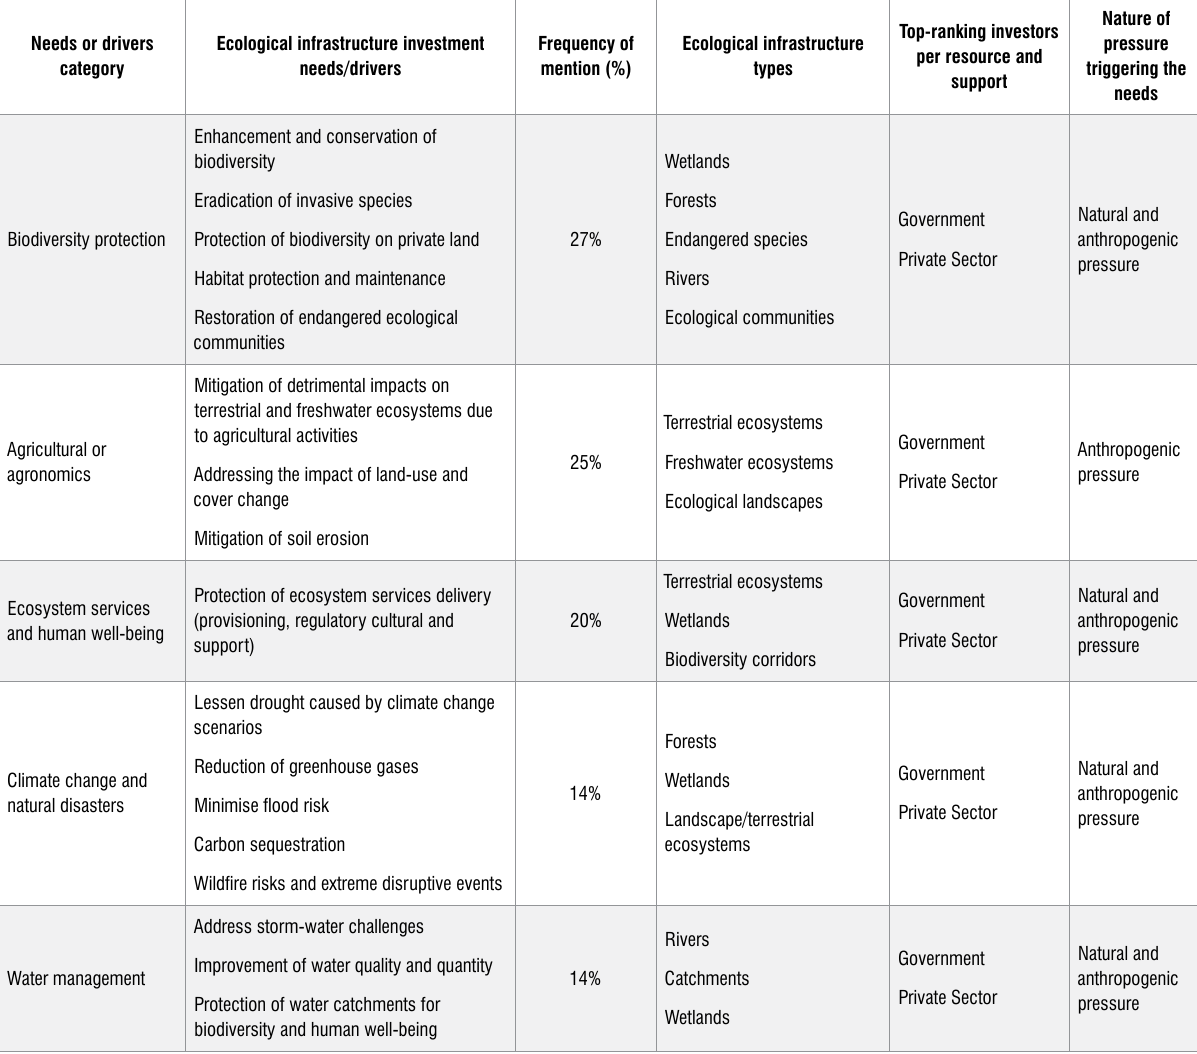
The needs or drivers that necessitate investments in ecological infrastructure by different investors. Categories of needs and drivers were derived from ATLAS. ti coding of n =152 sources reviewed.